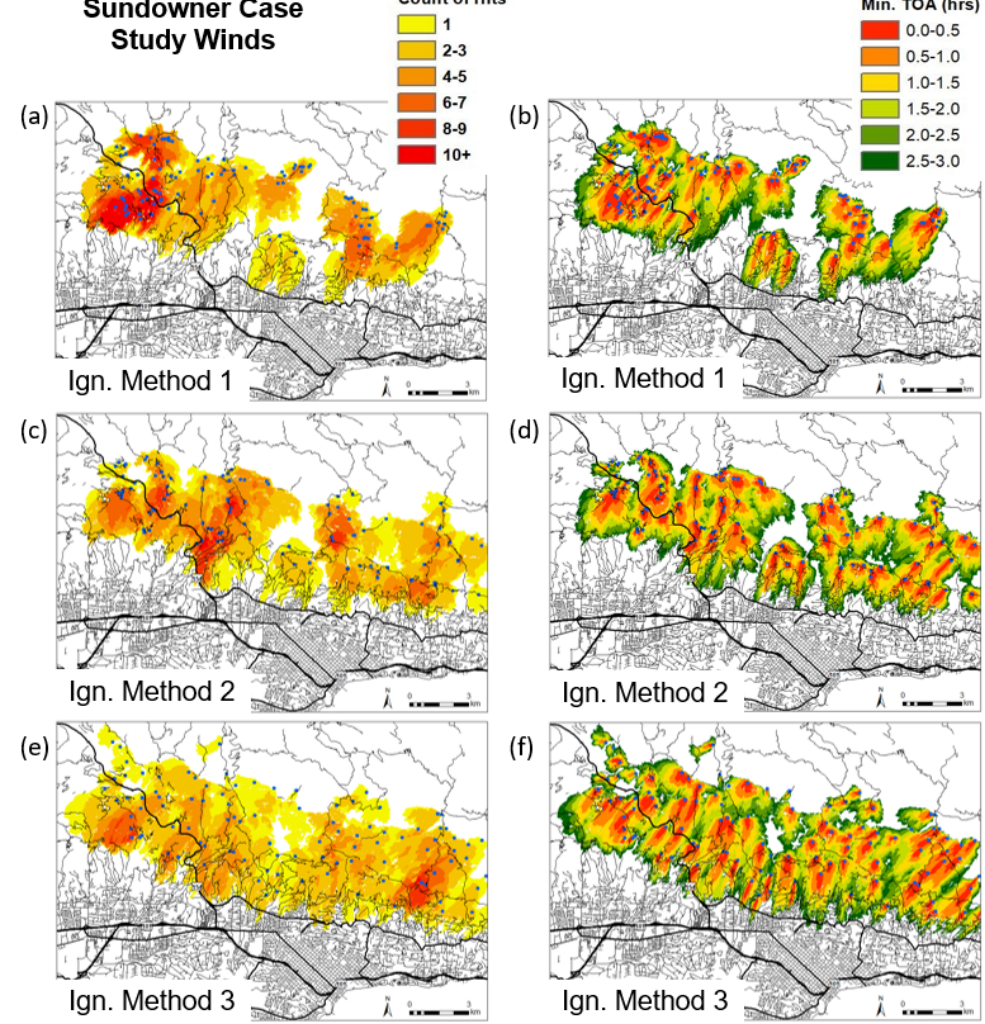
Figure 10. Same as Figure 5, but with wildfire simulations using the extreme Sundowner winds. Maps ( a ) and ( b ) show results from ignition method 1, ( c ) and ( d ) show results from ignition method 2, and ( e ) and ( f ) show results from ignition method 3.